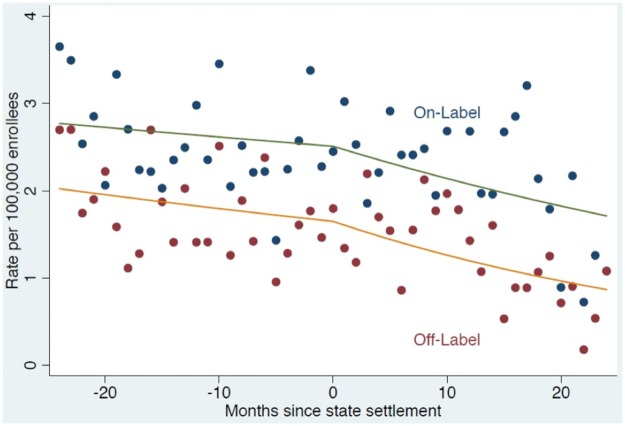
Time-series analysis of new adult users of olanzapine for on- and off-label indications before and after state off-label settlements.The 11 states that pursued and successfully settled independent state-level investigations were included in this analysis: Alaska, West Virginia, Connecticut, Idaho, South Carolina, Utah, New Mexico, Mississippi, Arkansas, Montana, Louisiana (Minnesota and Pennsylvania also pursued state investigations but had not yet reached a settlement at the time of this paper’s final submission). The figure shows aggregated incident utilization data for olanzapine among these 11 states, with the first time interval spanning the two years before each state’s settlement. The month of each state’s settlement served as the breakpoint for our analysis. The second time period spanned the two-year period following the state settlements.